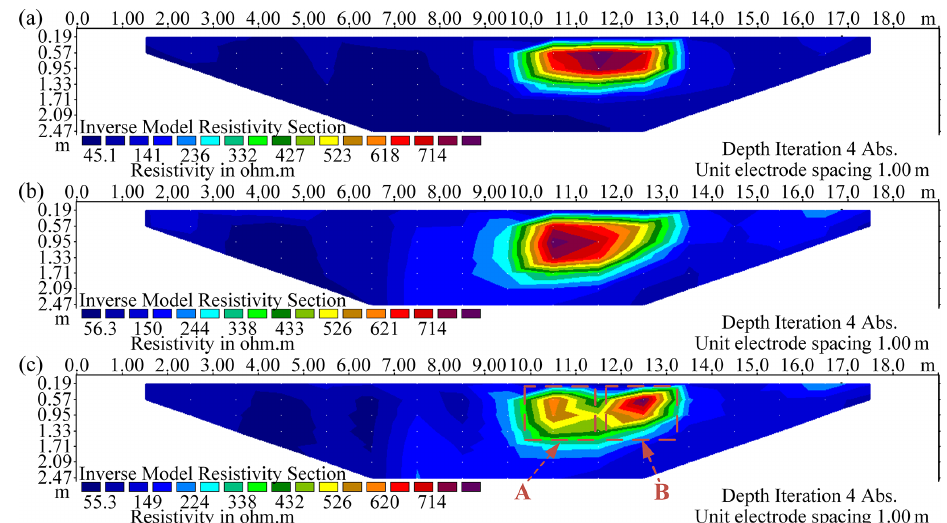
Figure 12. Inverted resistivity sections of the two high-resistivity anomalies (A and B) at 80Hz with using (a) the FDIP method, (b) the TSIP algorithm, and (c) the ECI algorithm.